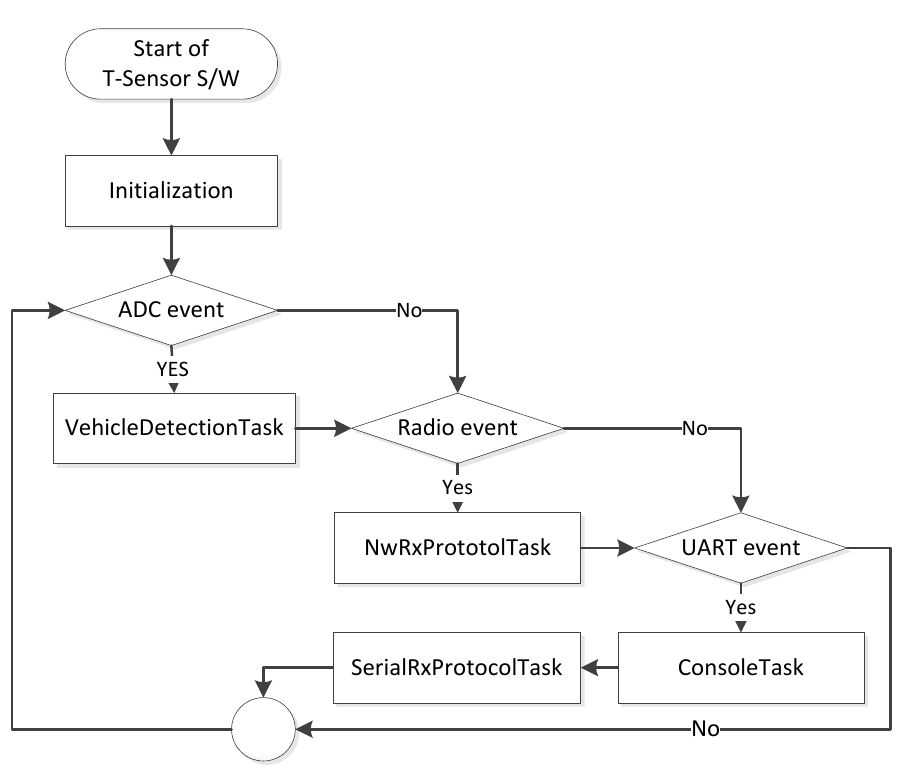
Figure 6. Overall operation procedure of T-Sensor node